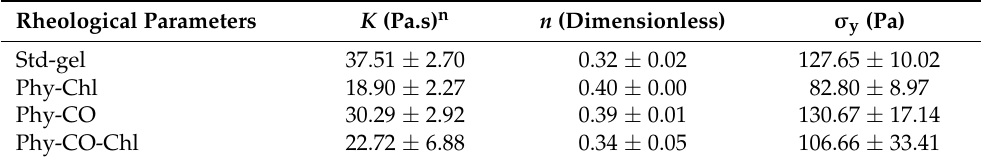
Table 5. Consistency index ( K ), flow behavior ( n ), and yield value ( σ y ) obtained with upward flow curve modeled by Ostwald–de Waele and Casson